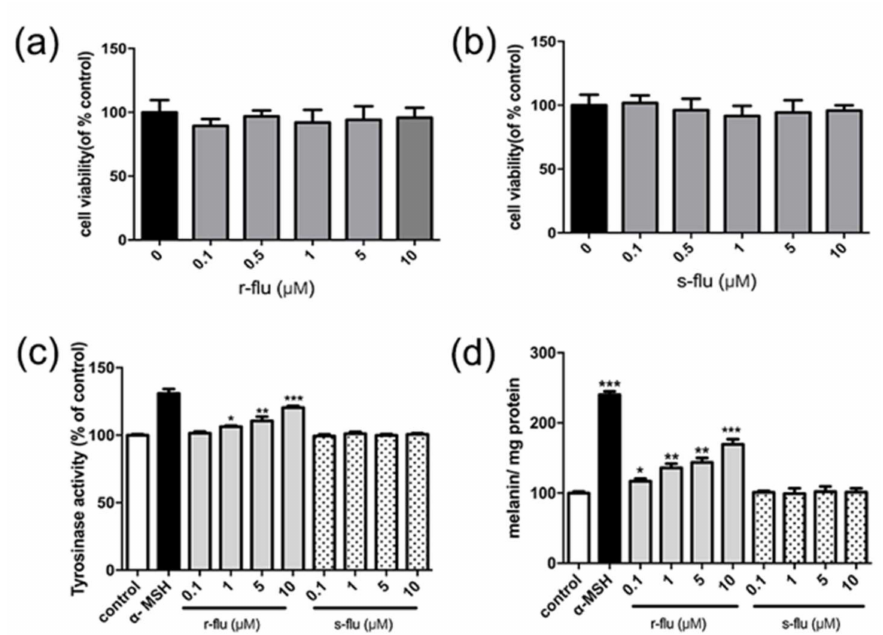
Figure 1. Effect of the r-fluoxetine and s-fluoxetine on the B16F10 cells viability, tyrosinase activity, and melanin content. B16F10 cells were incubated with r-fluoxetine and s-fluoxetine, at various concentrations, for 48 h, and the cell viability was examined by an MTT assay, r-fluoxetine ( a ) and s-fluoxetine ( b ). Tyrosinase activity ( c ) and melanin contents ( d ) were performed, as described in the Materials and Methods section. * p < 0.05, ** p < 0.01, *** p < 0.001, compared with